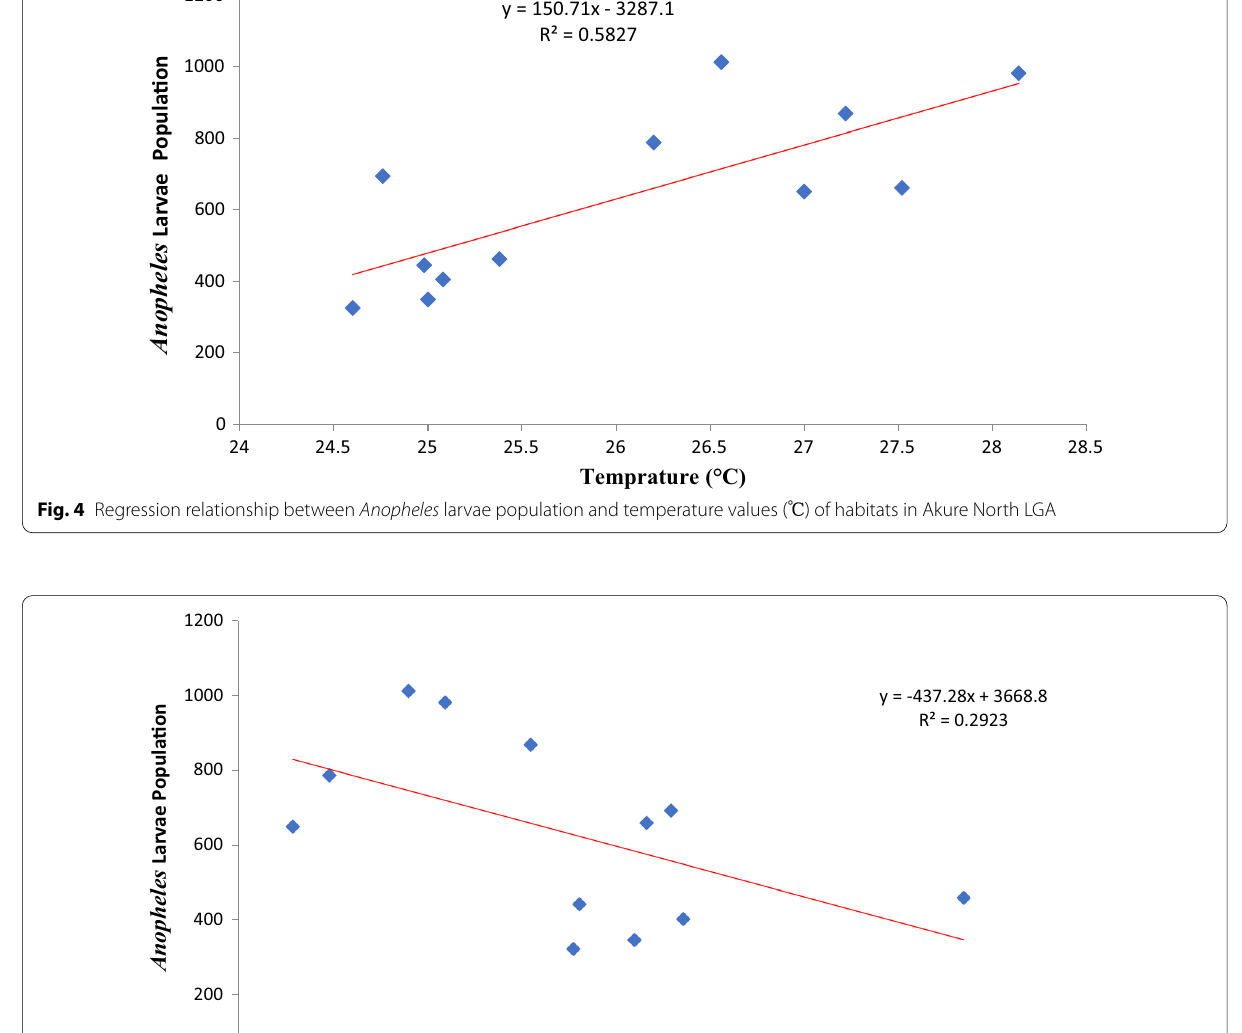
Fig. 5 Regression relationship between Anopheles larvae population and pH values of habitats in Akure North